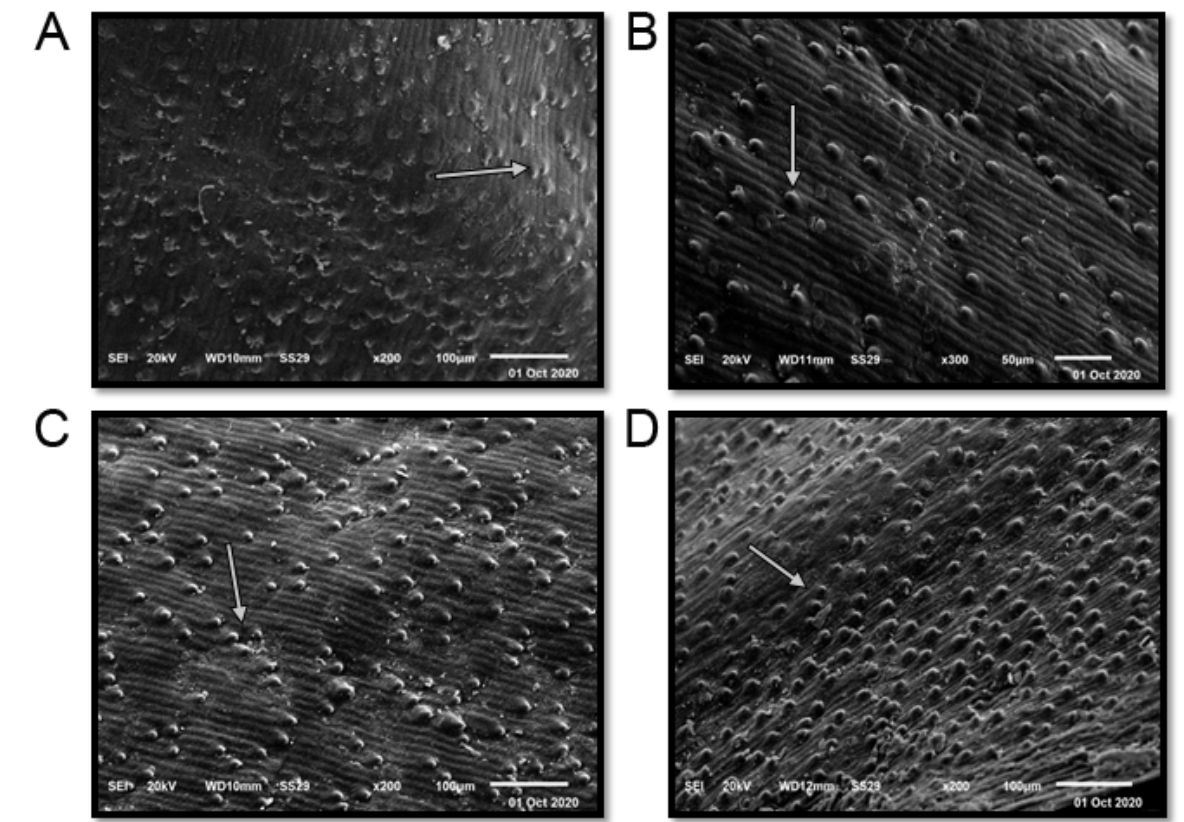
Figure 3. Scanning electron microscope (SEM) images of four Egyptian six-rowed barley ( Hordeum vulgare L.) cultivars: ( A ) Giza 123, ( B ) Giza 126, ( C ) Giza 136, and ( D ) Giza 138. Scale bar = 100 µm. White arrows indicate the quality and shape of the rugose.